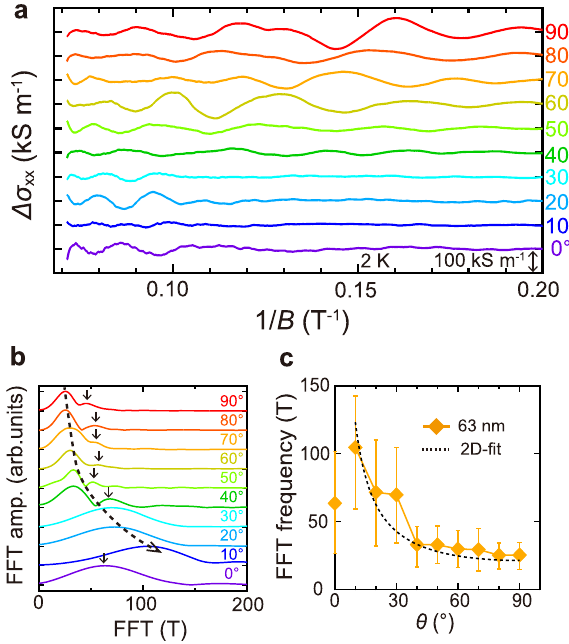
Fig. 8 Angular dependence of the SdH oscillations for the SrRuO 3 fi lm with t = 63 nm. a Angular dependence of the background- subtracted SdH oscillations at 2 K with B (5 T < B < 14 T) for the SrRuO 3 fi lm with t = 63 nm. b Angular dependence of the FFT spectra of SdH oscillations at 2 K for the fi lm with t = 63 nm. The dashed line is a guide for the peak shift of the two-dimensional Weyl fermions. Black solid arrows indicate the peak positions of the three- dimensional Weyl fermions. c Angular dependence of the FFT frequency. The dashed line is the fi tting of a two-dimensional angular dependence (~1/cos(90° − θ )).